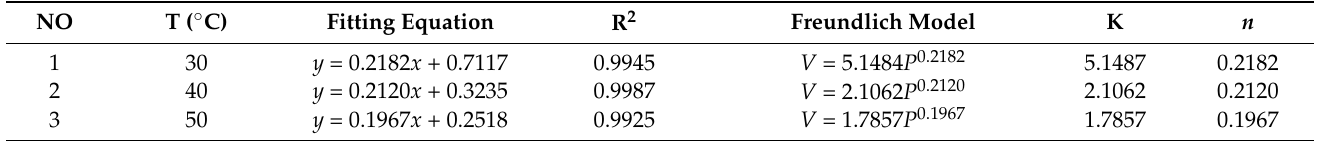
Figure 12. The relationship between adsorption amount and equilibrium pressure. Figure 12. The relationship between adsorption rate constant and equilibrium pressure. Table 4. The results of fitting methane adsorption isotherm at different temperatures.